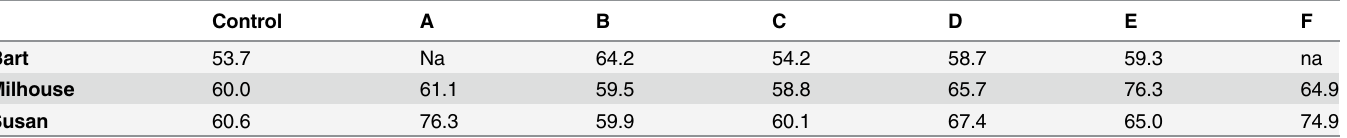
Table 3. Average chirp duration (ms).